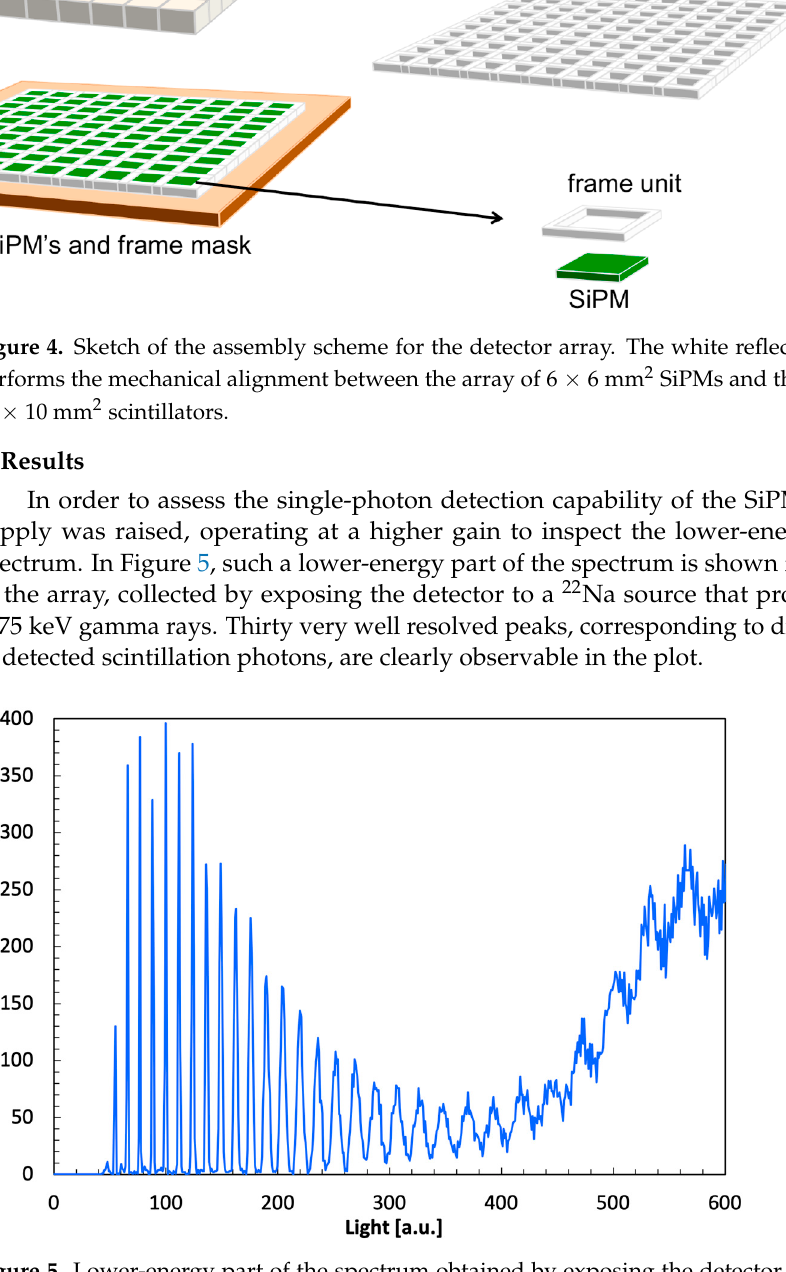
Figure 3. The detector components, from left to right: the scintillator array, the coupling frame mask and the SiPM array. On the four sides of the SiPM array board, the eight 26-pin dual header plugs for the output signals are visible, along with the bias voltage LEMO connector shown on the Figure 4. Sketch of the assembly scheme for the detector array. The white reflecting frame mask righthand side. performs the mechanical alignment between the array of 6 × 6 mm 2 SiPMs and the corresponding 10 × 10 mm 2 scintillators.